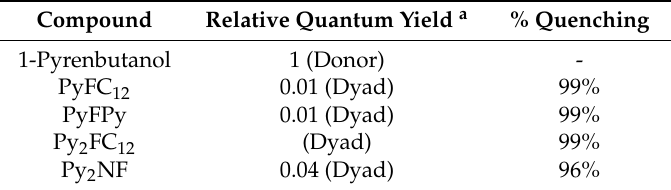
Table 4. Relative quantum yield and FRET efficiencies of the pyrene-fullerene C 60 compounds